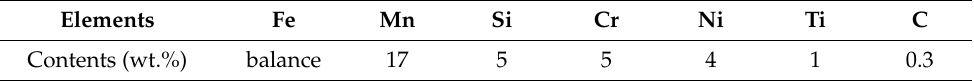
Table 1. Chemical composition of Fe-Mn-Si-based shape memory alloys (Fe-SMA).